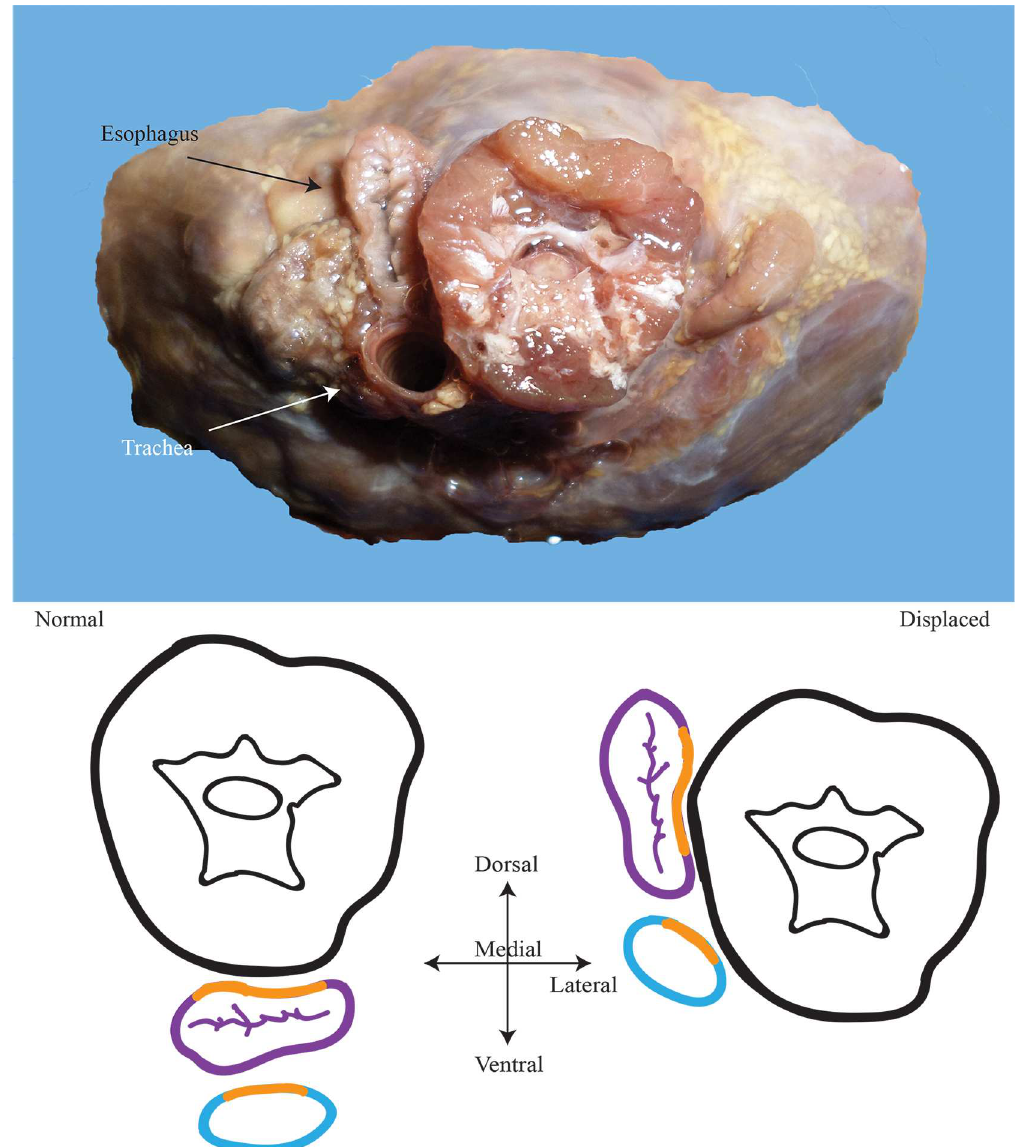
Fig 17. Rotation of the organs. Top: bird neck cut to show the extent of rotationof the trachea and esophagus. Bottom:Illustrationsof normalityand displacement.Bottomleft: an illustrationof the normal,midsagittal, condition. Bottomright:an illustrationof trachealand esophagealdisplacement.Rotationis evident. Orange lines outlinethe mid-dorsal portionsof the organs. In TED, the organscan be seen to have been rotatedso that their mediodorsal points face inward toward the vertebral